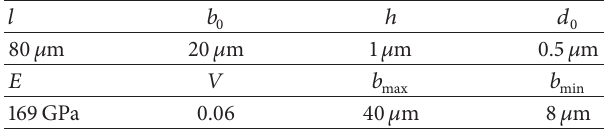
Table 4: Dimension and physical parameters of a typical fixed-fixed